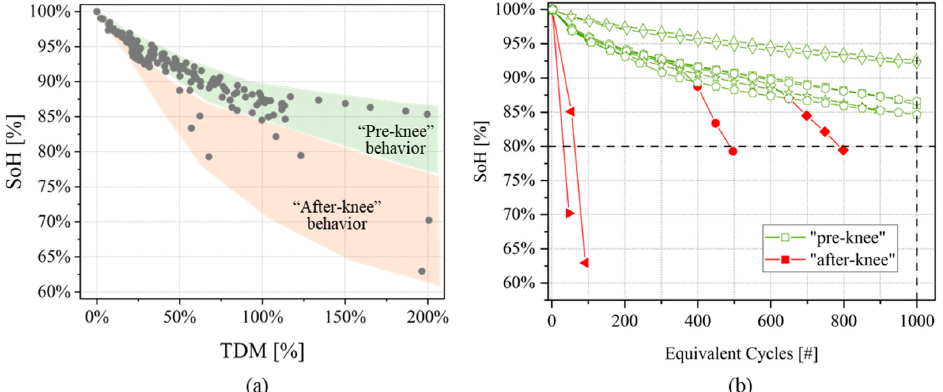
Figure 5. ( a ) SoH evolution over 𝑇𝐷𝑀 (cid:3036) (cid:4670)%(cid:4671) values for the cells under investigation. Two regions are Figure 5. ( a ) SoH evolution over TDM i [ % ] values for the cells under investigation. Two regions depicted, corresponding to “pre-knee” and “after-knee” behaviors; and ( b ) validation of ∆R Ω,(cid:3036) are depicted, corresponding to “pre-knee” and “after-knee” behaviors; and ( b ) validation of ∆ R Ω , i threshold equal to 1%, identifying all the points with “after-knee” behavior. threshold equal to 1%, identifying all the points with “after-knee”